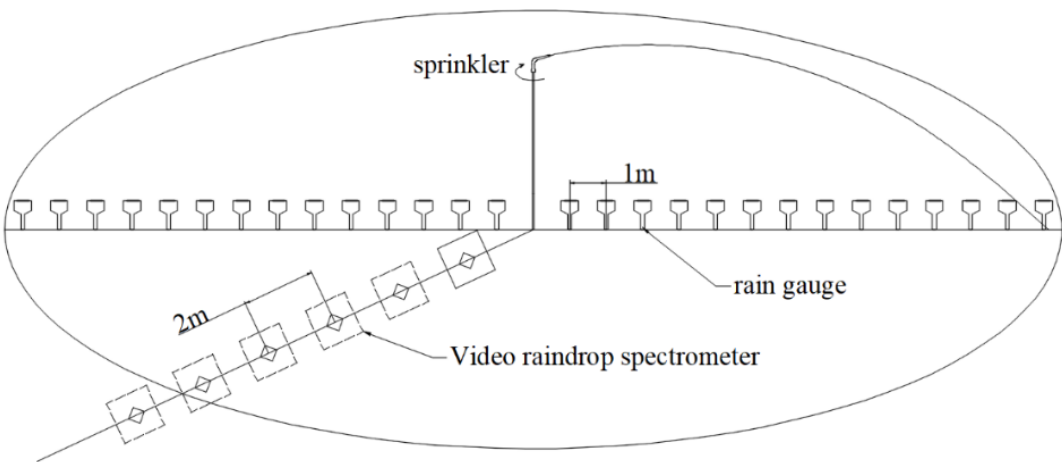
Figure 5. Schematic layout of the experimental system.